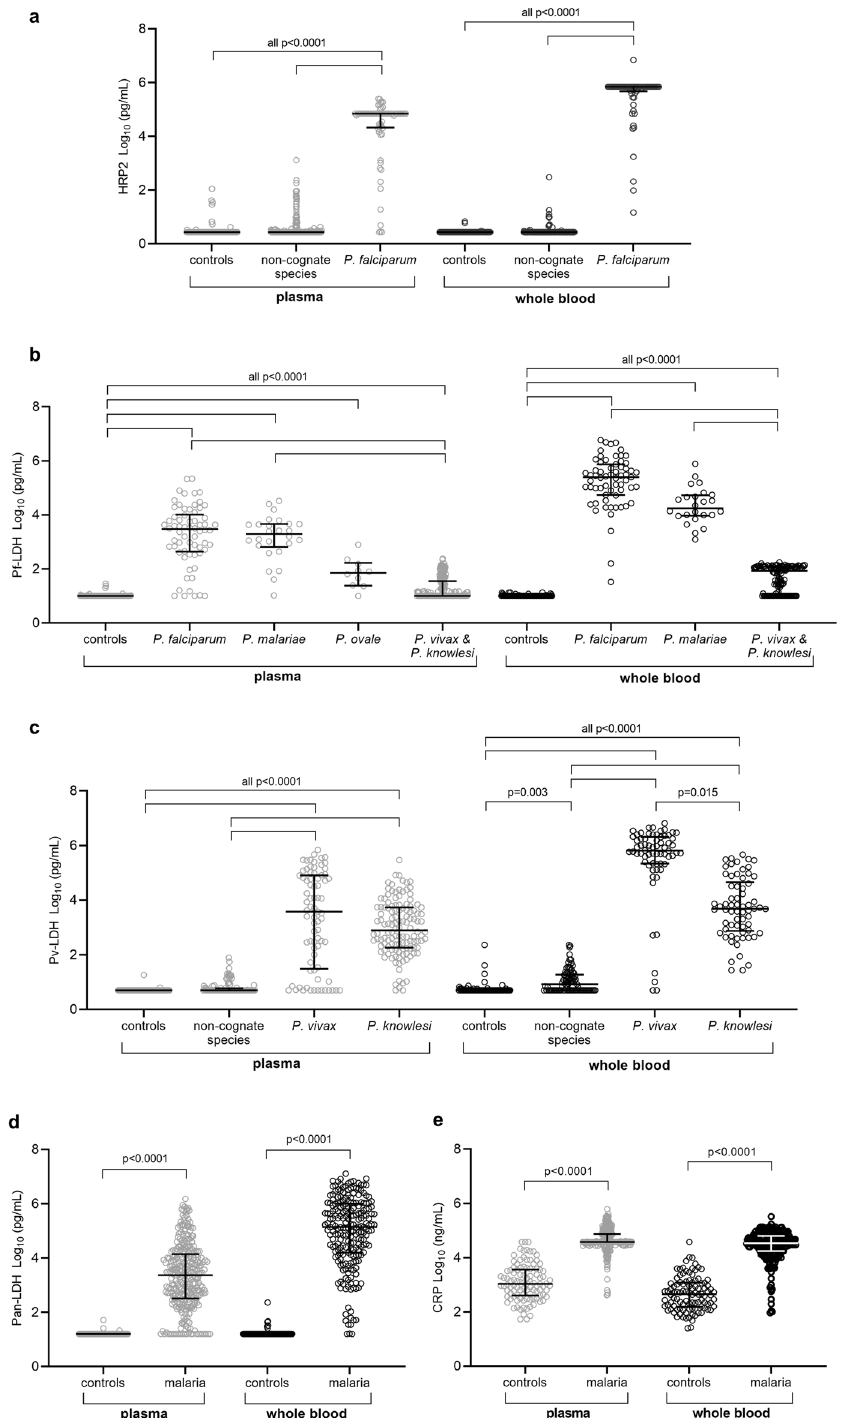
Figure 1. Distribution of malaria antigen concentrations in malaria patients and controls. Scatter plots of the concentration of histidine-rich protein-2 ( a ), P. falciparum lactate dehydrogenase (Pf-LDH) ( b ), P. vivax LDH (Pv-LDH) ( c ), Pan Plasmodium LDH (Pan-LDH) ( d ) and C-reactive protein (CRP) ( e ) were determined in plasma and whole blood samples. Refer to Table 1 for sample sizes. Non-cognate species in A correspond to Pv, P. knowlesi (Pk), P. malariae (Pm) and P. ovale (Po; plasma only); and in C correspond to Pf, Pm and Po. Antigen concentrations were log transformed. Individual datapoints with median and interquartile-range shown. The Kruskal–Wallis test with Dunn’s multiple comparison was used in ( a )–( c ), and the Man-Whitney test in ( d ) and ( e ). A P -value < 0.05 was considered statistically